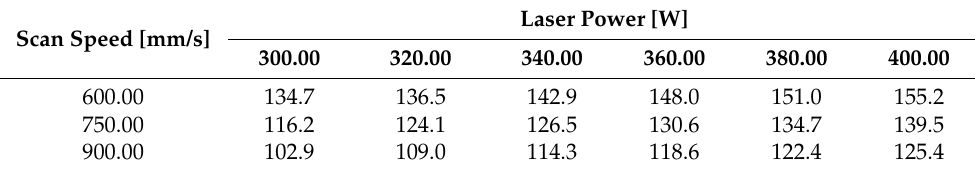
Table 4. Single track width for different combinations of scanning speed and laser power [µm]. Scan Speed [mm/s]